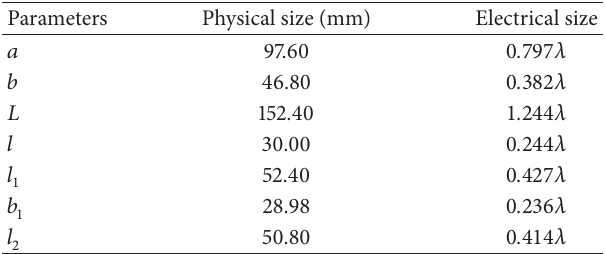
Table 2: Parameters of the antenna with the parasitic coupling apertures.